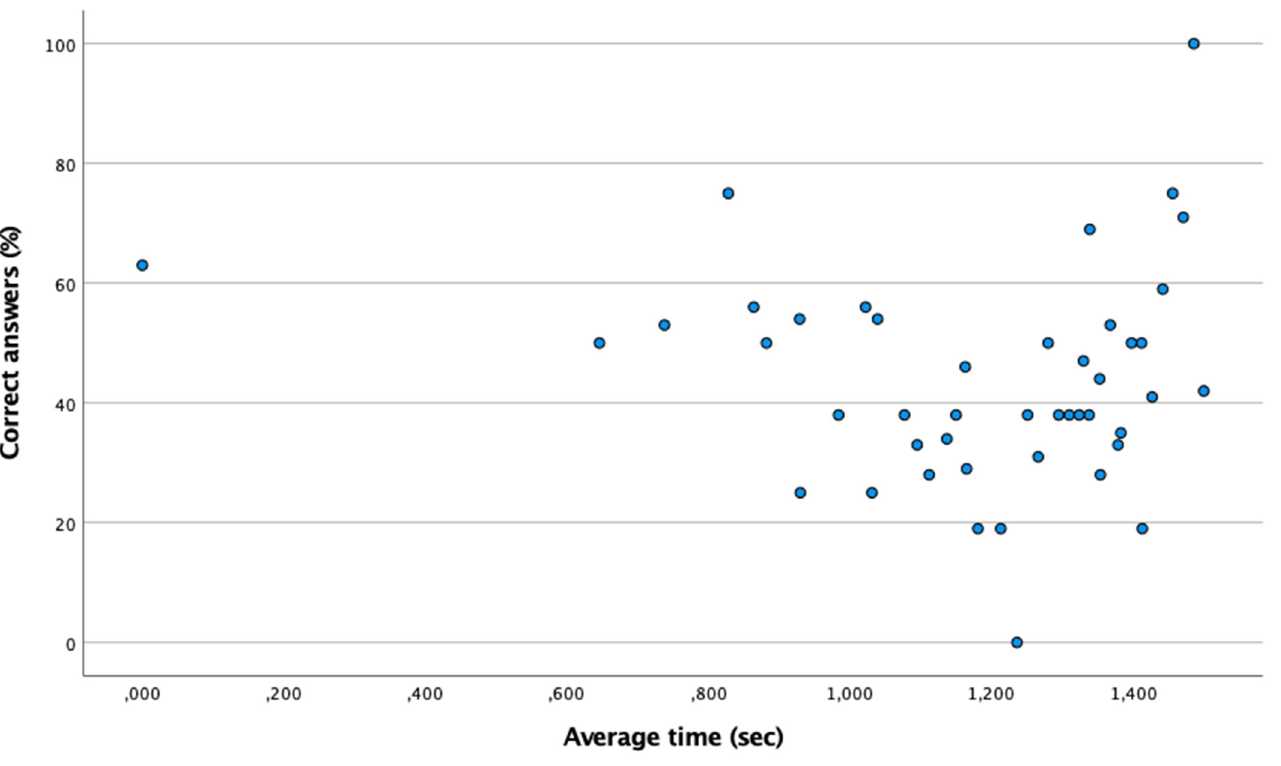
Figure 5. Absence of relationship between the percentage of correct answers and the mean time in the attention and peripheral response.